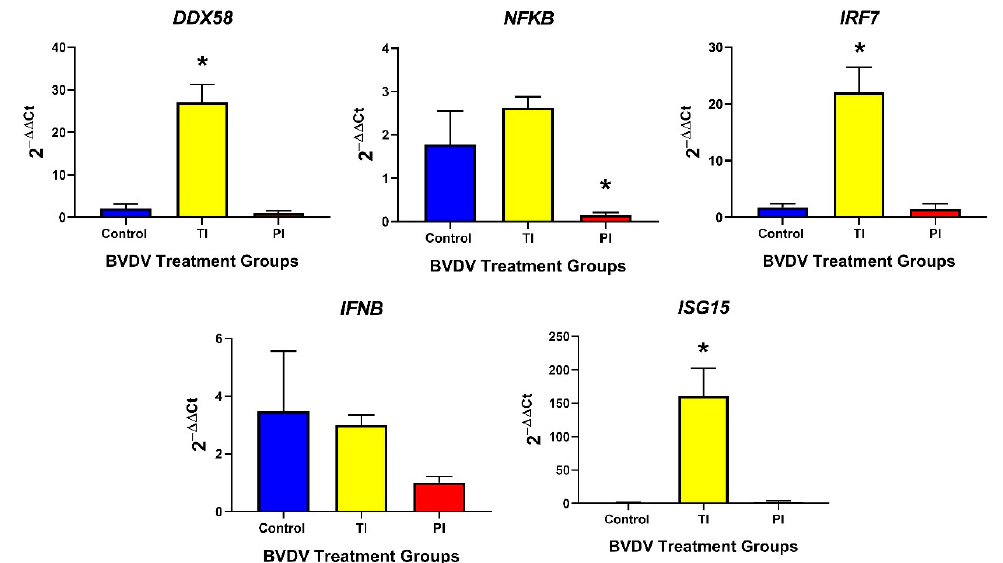
Figure 4. Spleen (Control, TI, and PI) expression of transcripts associated with the innate immune response. TI fetal spleens exhibited an upregulation of DDX58 , IRF7 , and ISG15 compared to controls, indicating an active type I IFN response. In PI fetal spleens, only NFKB was downregulated compared to controls. TI: Transiently Infected, PI: Persistently Infected. * p < 0.05.